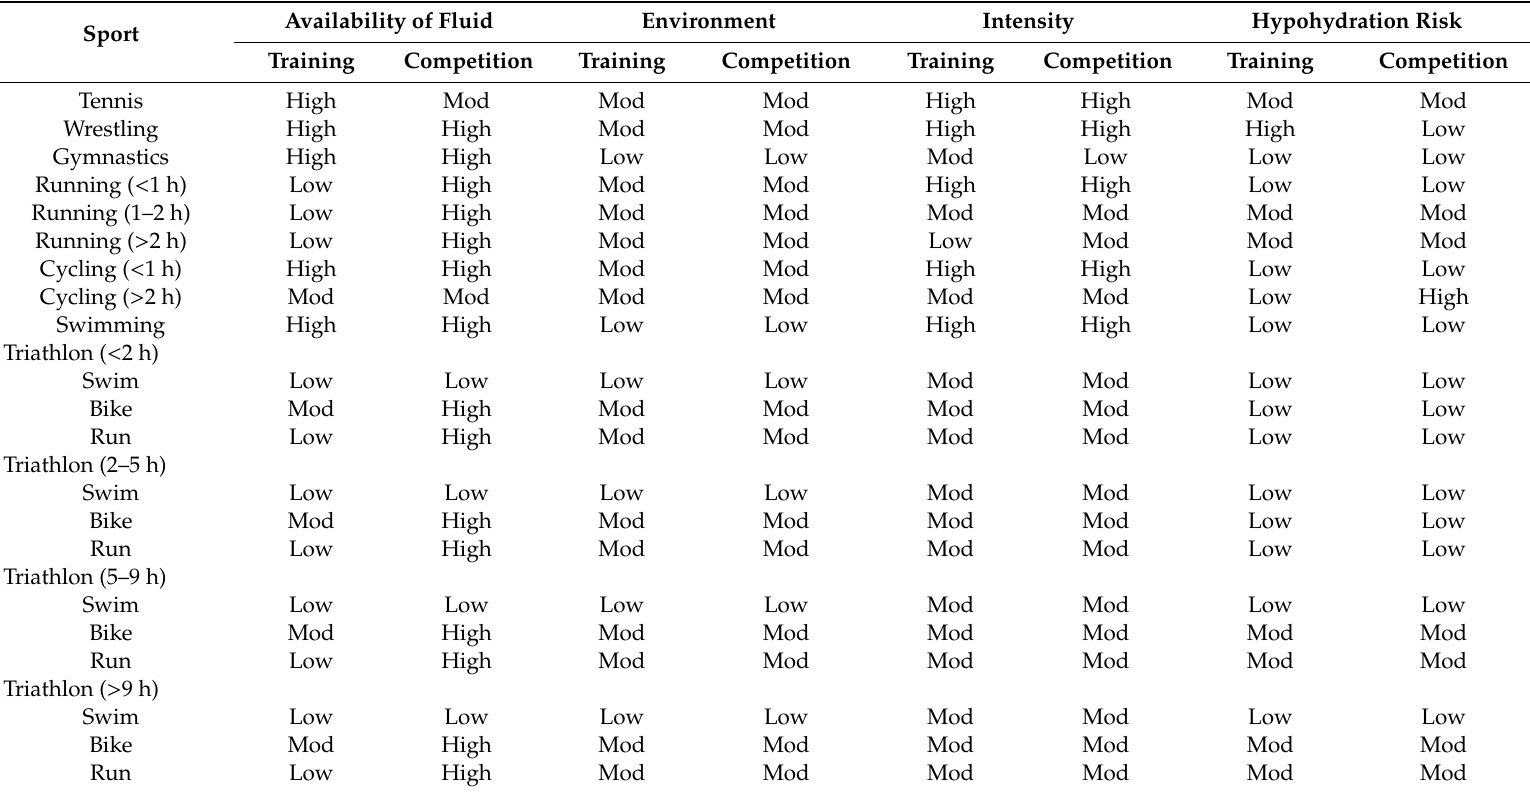
Table 2. Individual Sport Factors That Influence